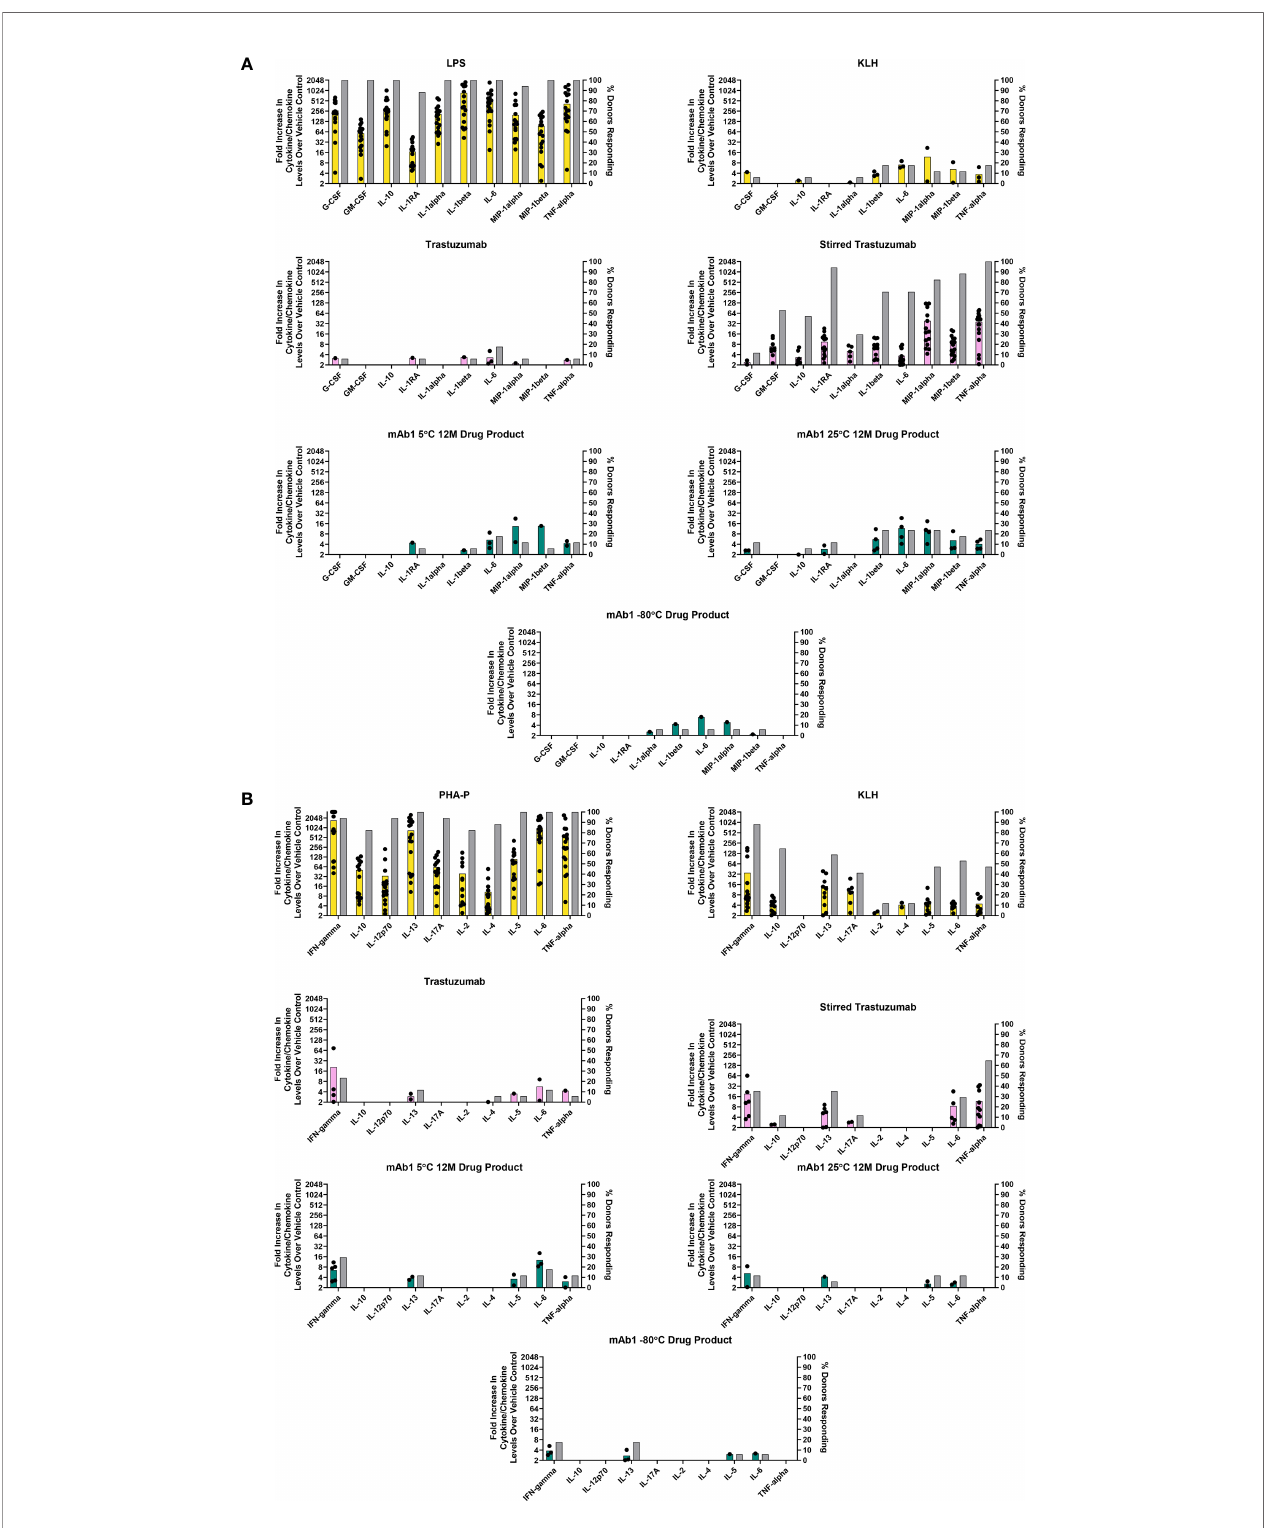
FIGURE 2 | In vitro PBMC responses to spontaneously occurring antibody aggregates obtained from stability samples stored at different temperatures. Colored bar graphs correspond to the left Y-axis and represent the mean of positive donor responses (fold increase ≥ 2 is considered positive). Black dots show the individual donors that had a positive response. The grey bars correspond to the right Y-axis and represent the proportion of donors with positive responses to a particular analyte. (A) Innate immune responses measured at 20 hrs. (B) Adaptive immune responses measured on day 7. Data are from 17